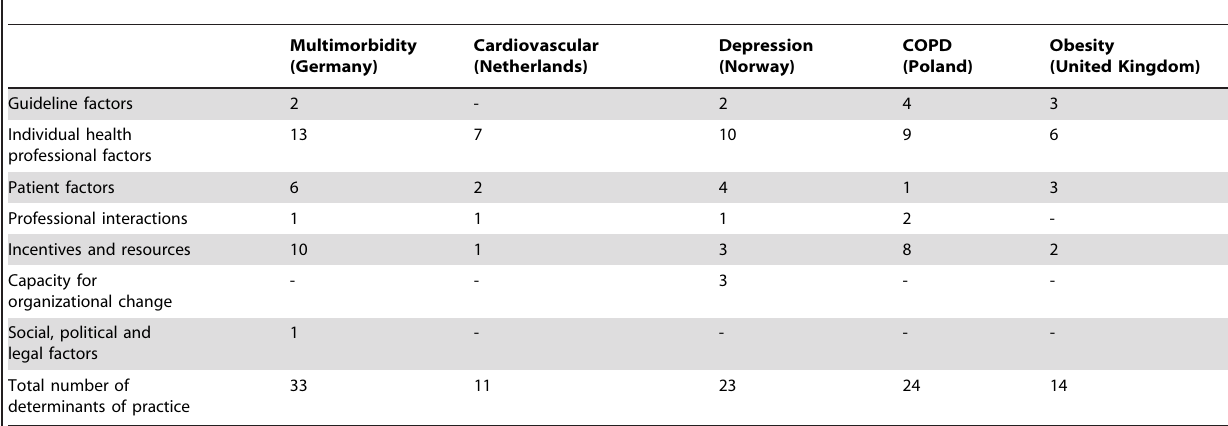
Table 1. Determinants given to groups mapped out onto the TICD framework